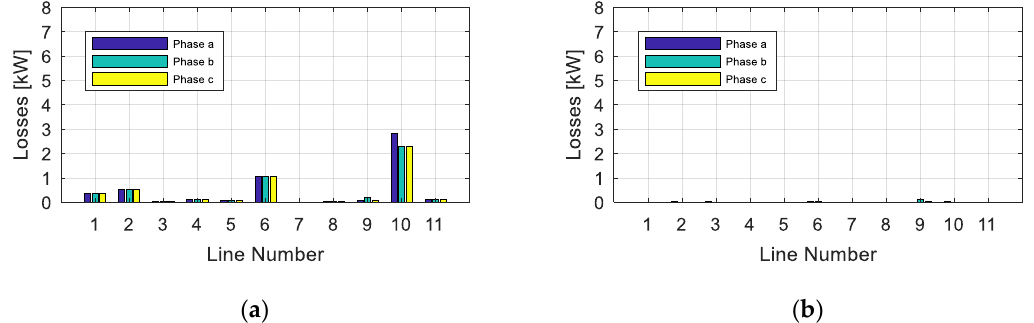
Figure 14. Scenario 3: Line losses at the hours: ( a ) Peak-H and ( b ) Peak-L.